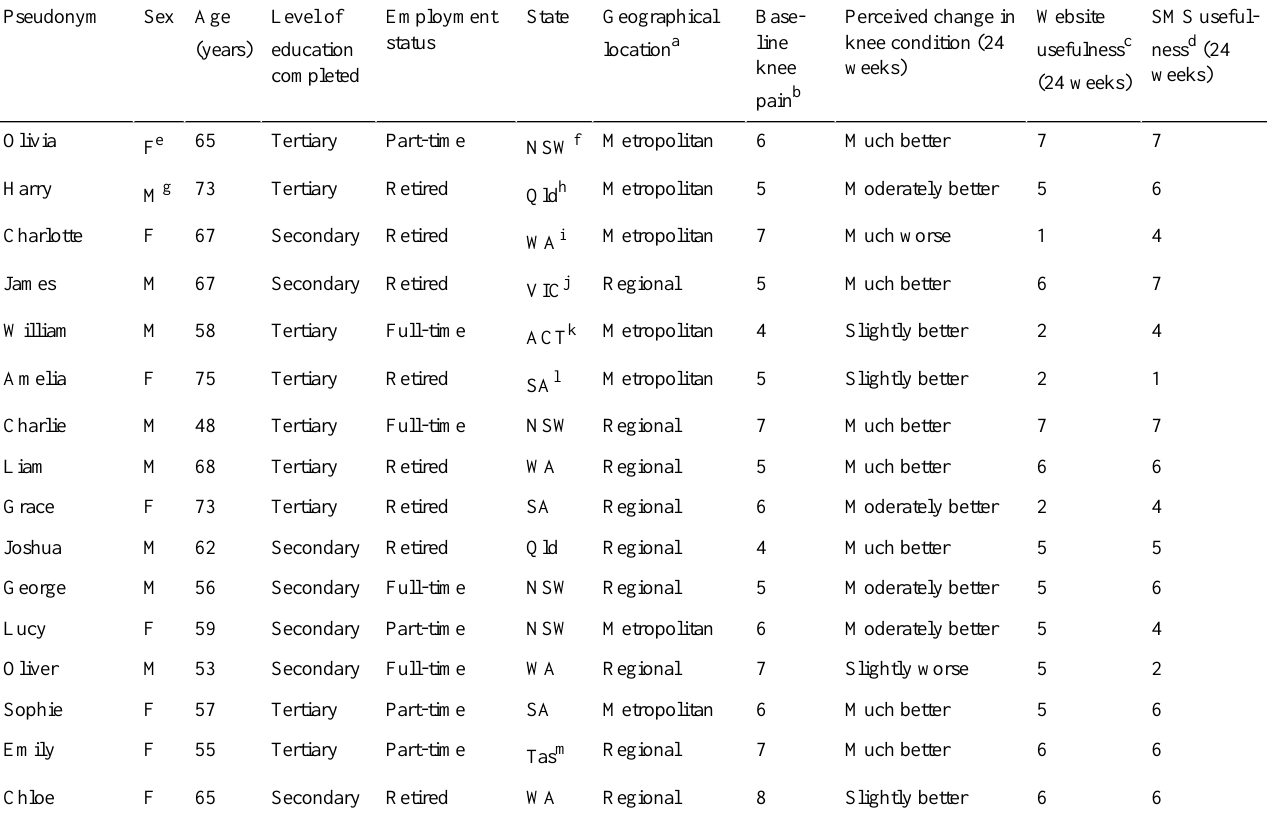
Table 1. Participant details